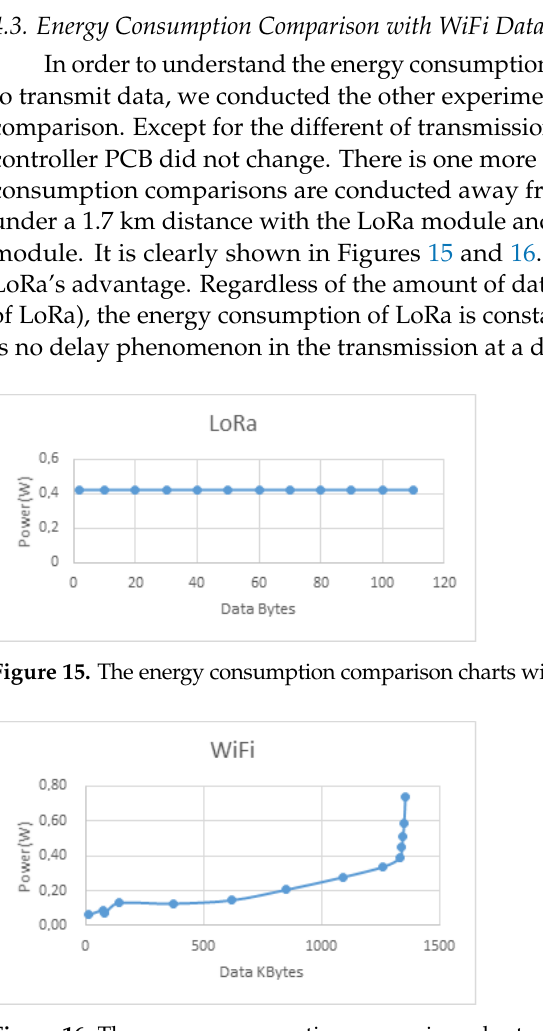
Figure 16. The energy consumption comparison charts with a WiFi module under a 15 m